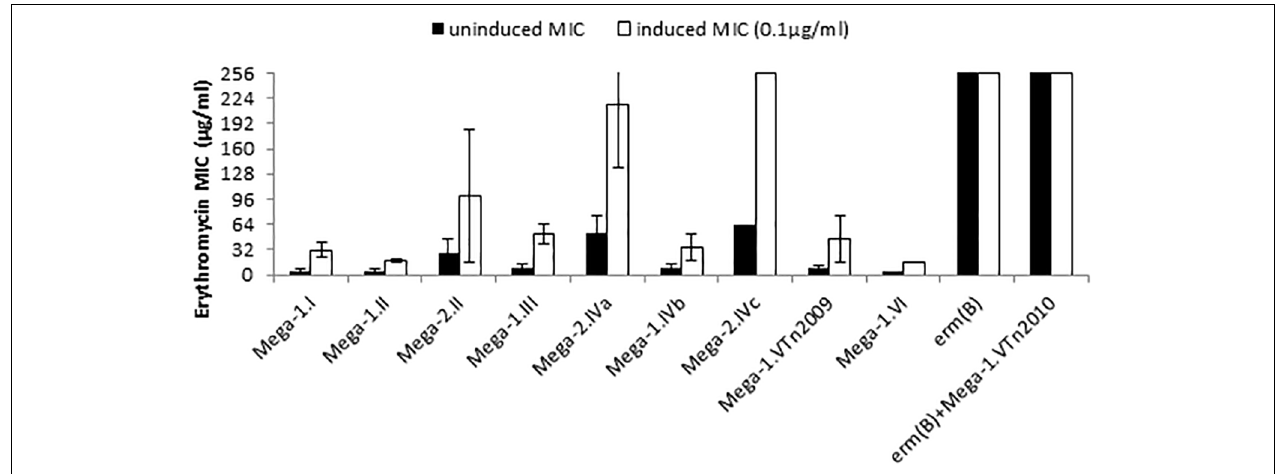
FIGURE 1 | Macrolide resistance phenotypes and genotypes of S. pneumoniae . Erythromycin minimum inhibitory concentrations (MICs) were determined under uninduced conditions (black bars) and cultures induced with 0.1 µ g/ml erythromycin (white bars). Each bar is the average MIC for a macrolide resistance genotype and strains in each group are detailed in Table 1